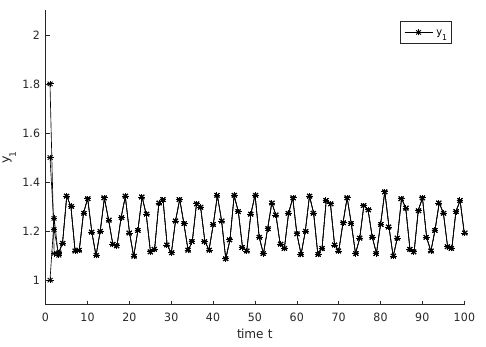
( t ) of system (4.9) with the initial conditions y * 1